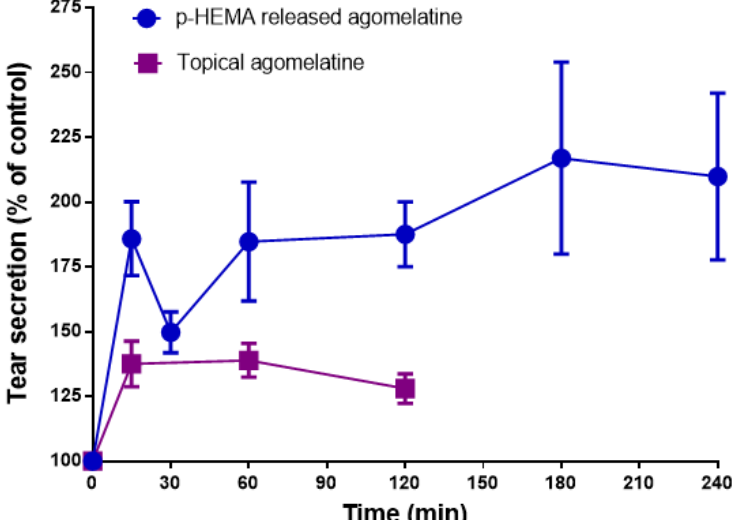
Figure 7. The effect of agomelatine released from CLs and administered topically in tear secretion. The P-HEMA lenses were preloaded with agomelatine 100 µ M for 12 h and 10 µ L of agomelatine 100 µ M was administered topically on rabbit eyes. Tear secretion was evaluated over 240 min (for CLs experiments) and over 180 min (for topical experiments), versus the basal tear secretion and tear secretion after topical application of a saline solution containing 1% DMSO, respectively (100% tear secretion). Tear secretion values (%) are presented as the mean ± S.E.M. of n = 12 lenses and n = 24 rabbit